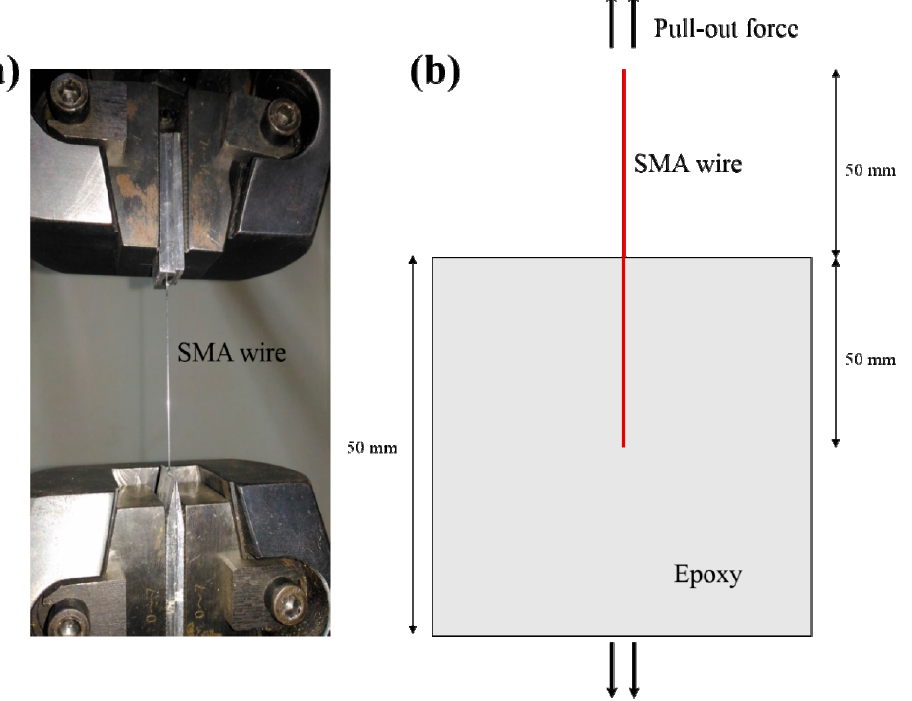
Figure 2. Quasistatic tensile test ( a ) individual SMA wire and ( b ) SMA/epoxy pull-out